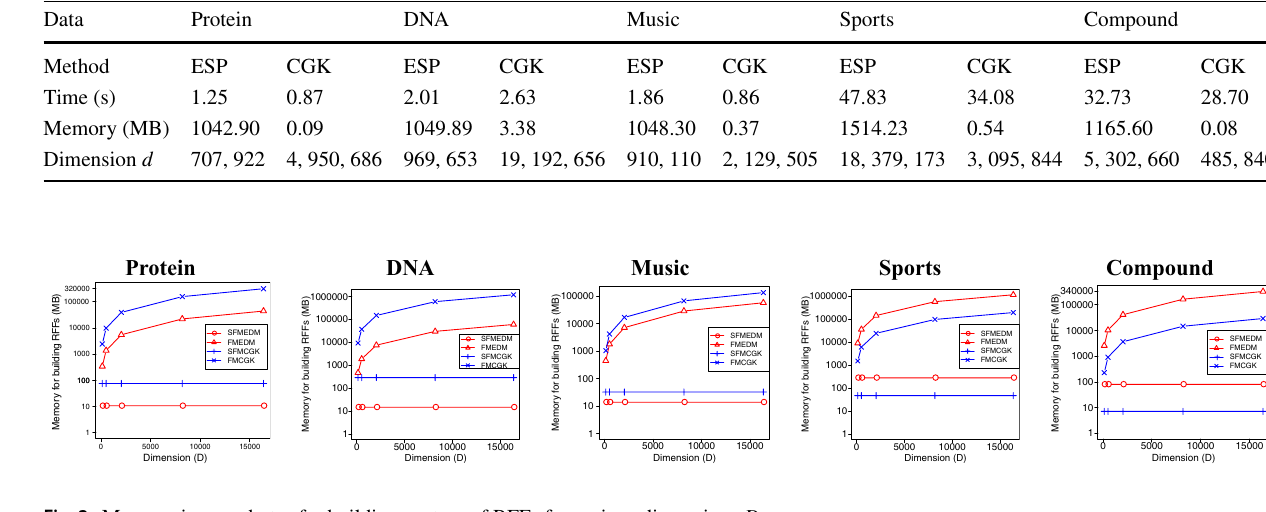
Fig. 2 Memory in megabytes for building vectors of RFFs for various dimensions